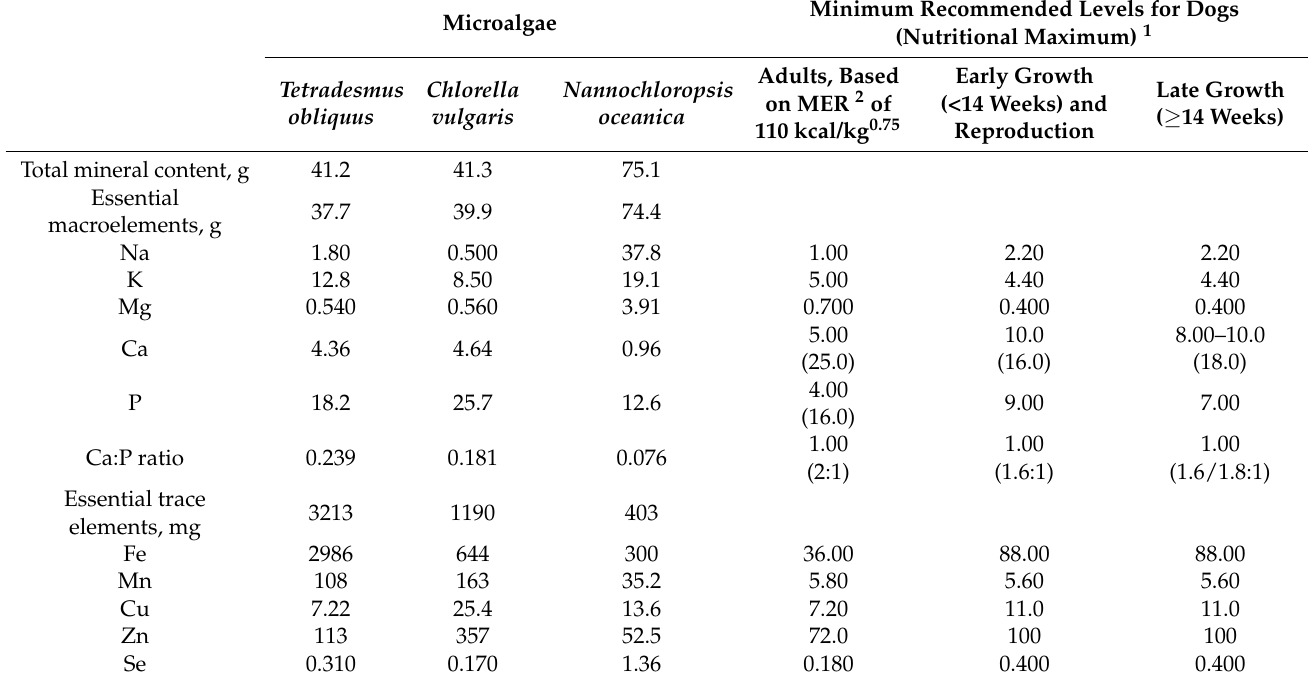
Table 5. Content of essential macro- and trace elements (unit per kg of dry matter) in the studied microalgae species and recommended values for